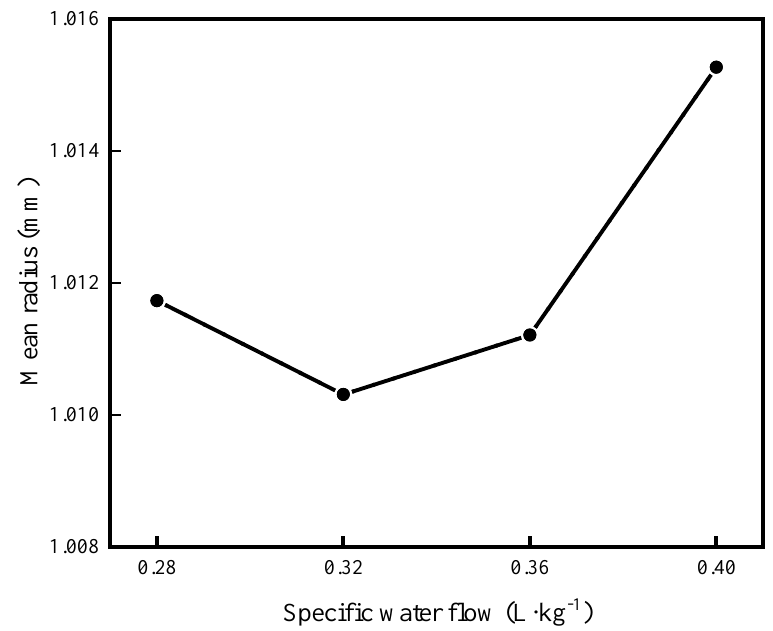
Figure 11. The average grain size of the slab with different specific water flow.